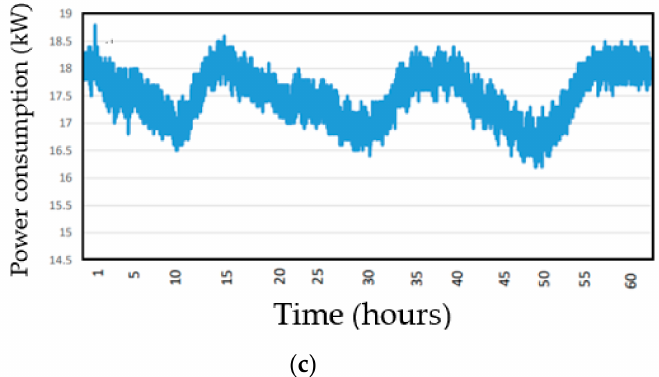
Figure 9. Power consumption of the heat pumps with auxiliary cooling subsystem in operation. ( a ) Power consumption of the first heat pump. ( b ) Power consumption of the second heat pump. ( c ) Power consumption of the third heat pump.